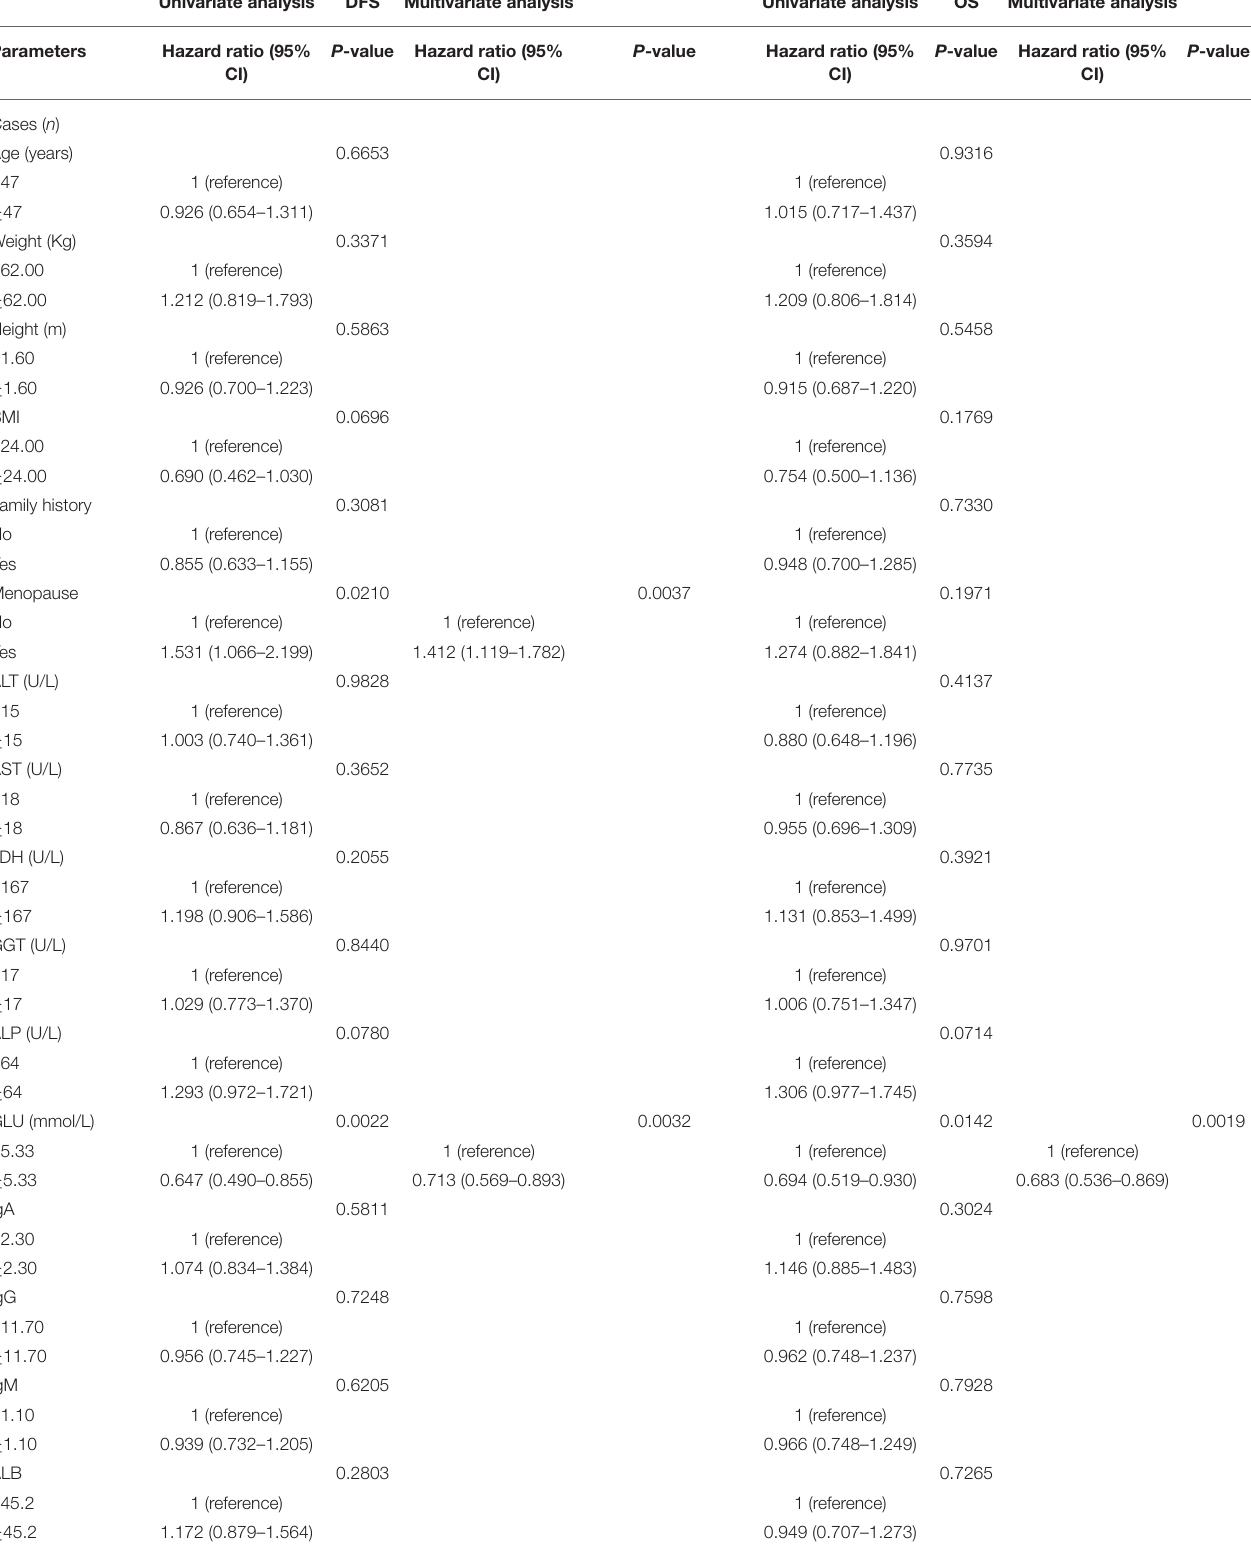
TABLE 3 | Univariate and multivariate cox regression survival analyses of the NRI for the prediction of DFS and OS in the participants. Univariate analysis DFS Multivariate